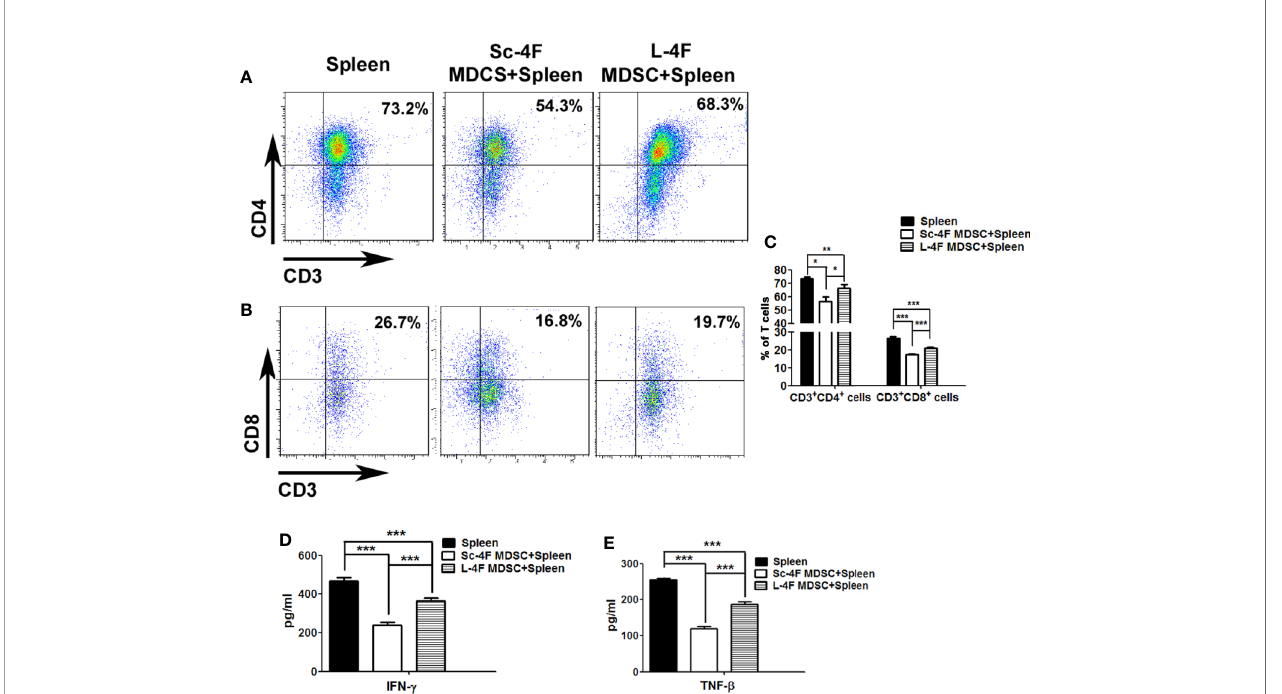
FIGURE 4 | L-4F blocks the immunosuppressive function of MDSCs Ly6G + Ly6C + MDSCs were isolated from the Sc-4F- or L-4F-treated mice and co-cultured with splenocytes from normal mice. (A, B) One representative result from each experiment is shown. (C) The percentages of CD3 + CD4 + T cells and CD3 + CD8 + T cells in